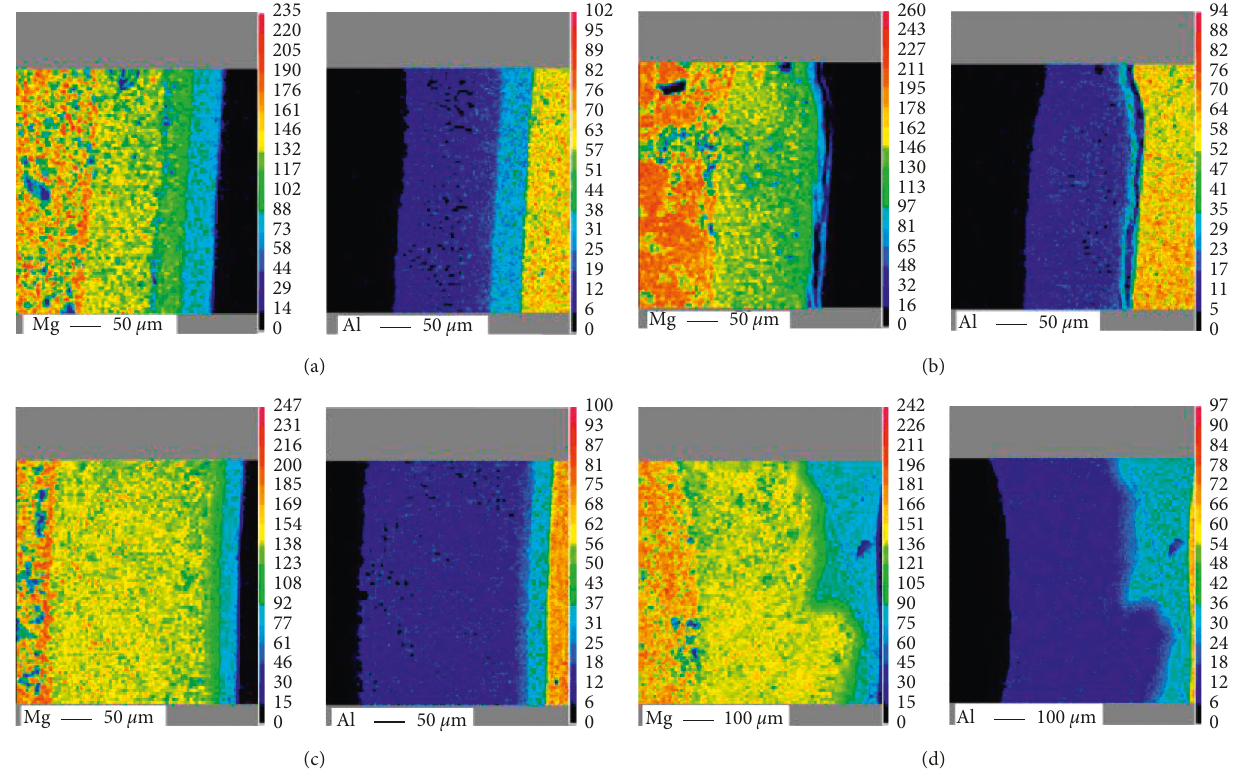
Figure 6: Results of elemental analysis, surface scanning: (a) without annealing and annealing at (b) 200 ° C, (c) 250 ° C, and (d) 300 °